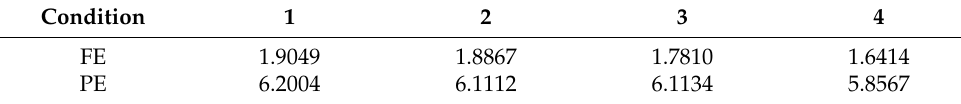
Table 1. Measures under different fault